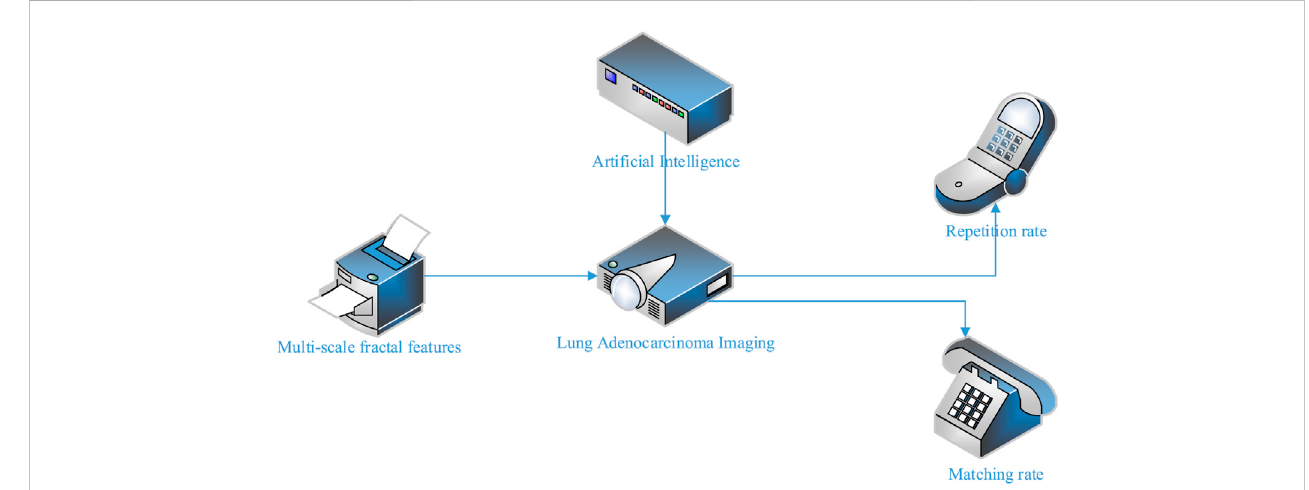
FIGURE 1 AI-based LUAD image feature recognition algorithm.